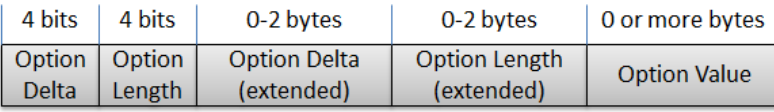
Figure 14. CoAP Option